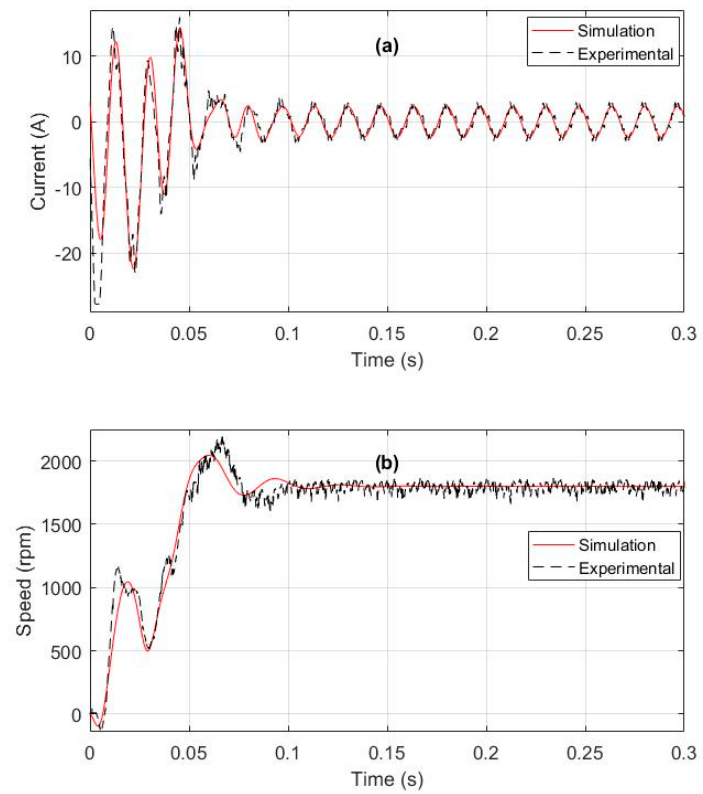
Figure 20. LSPMSM under 2 N · m load ( a ) Stator phase A Current ( b ) speed.